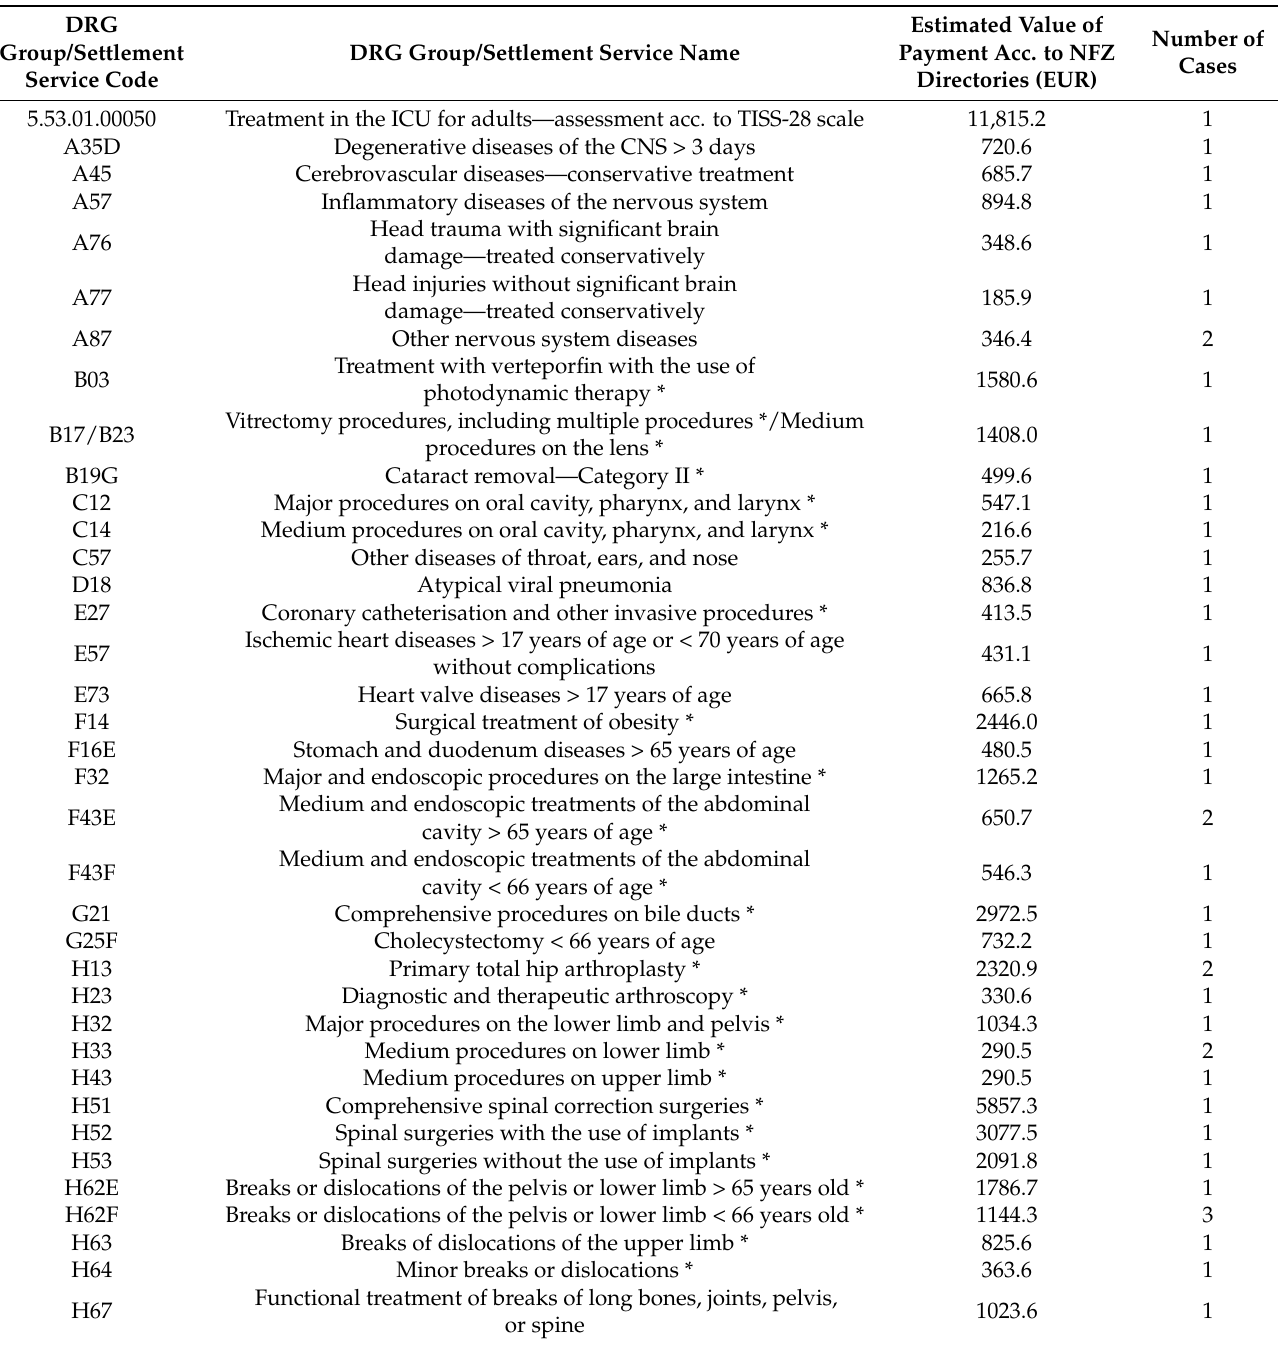
Table 1. Type of provided services, their number, and costs of treatment of primary disease in accordance with the directories by the National Health Fund